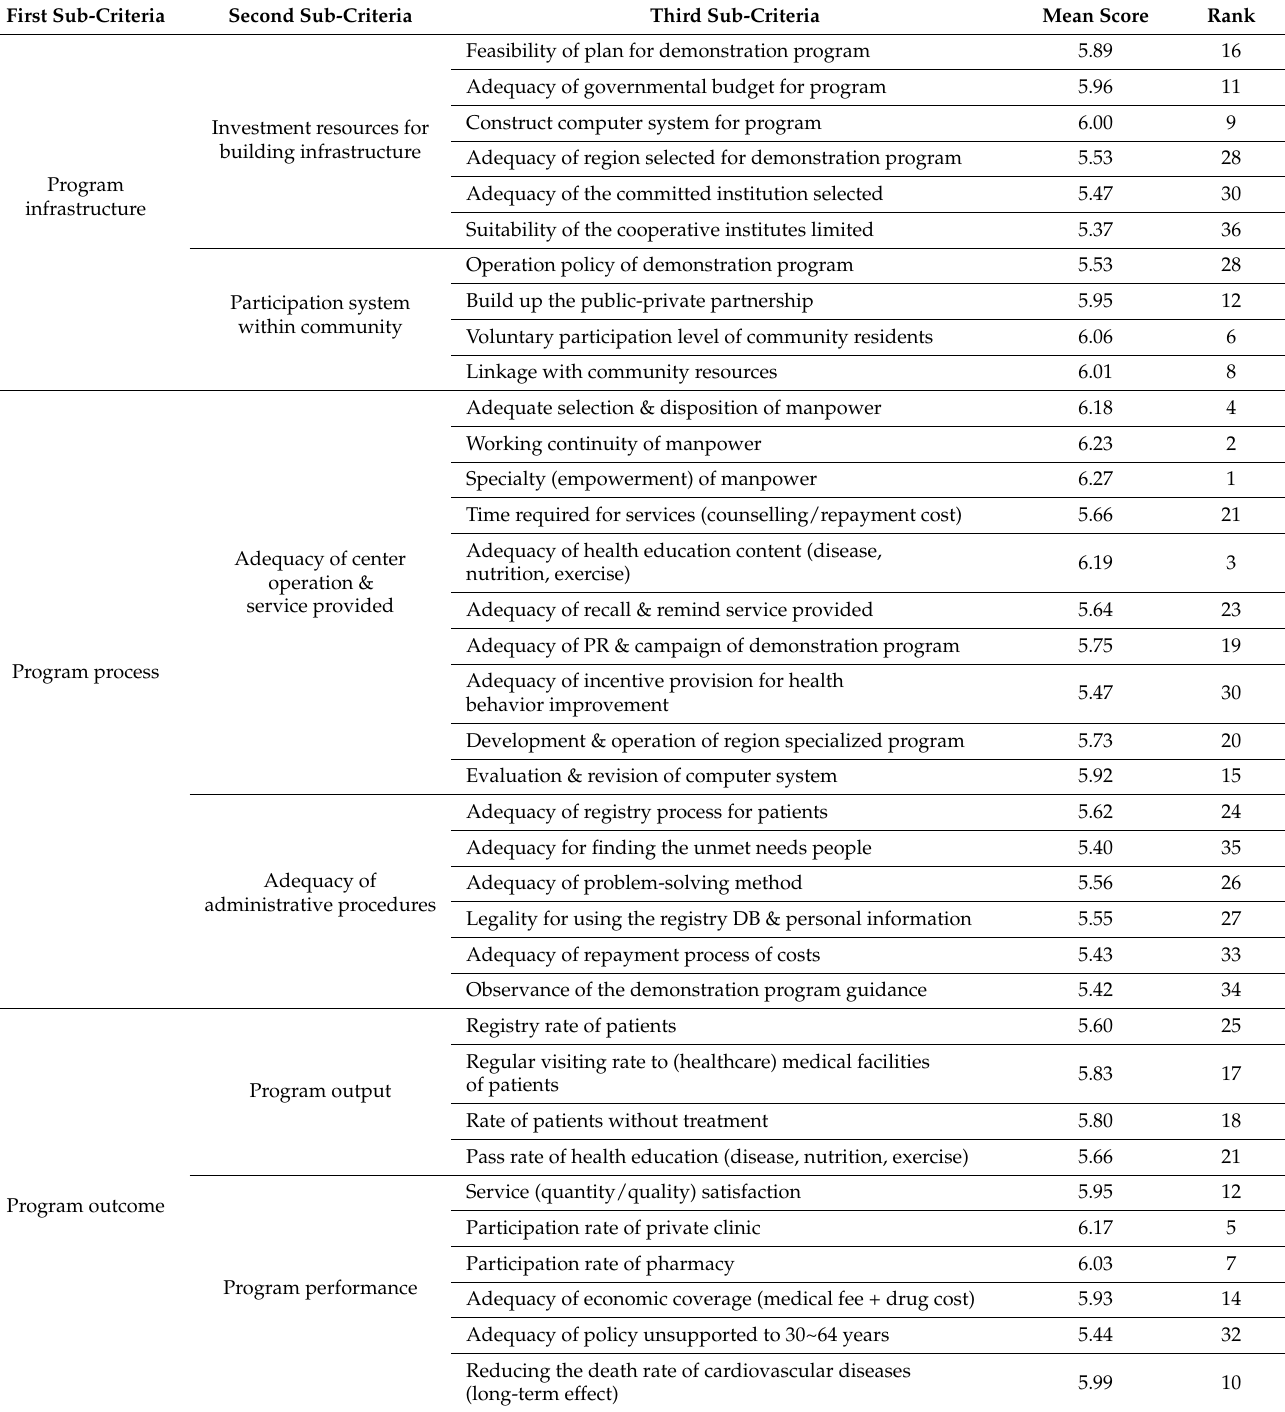
Table 3. Relative importance by evaluation criteria of community-based intervention program to approach strategy for healthcare system (community